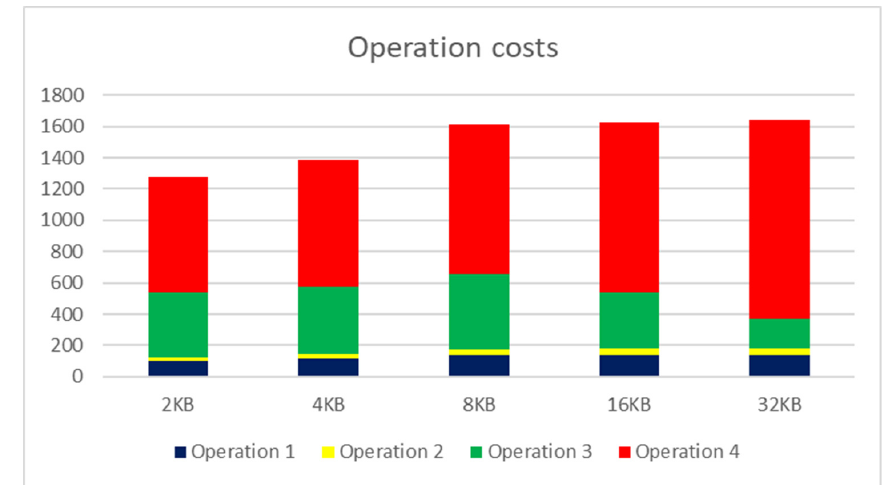
Figure 19. Operation costs.